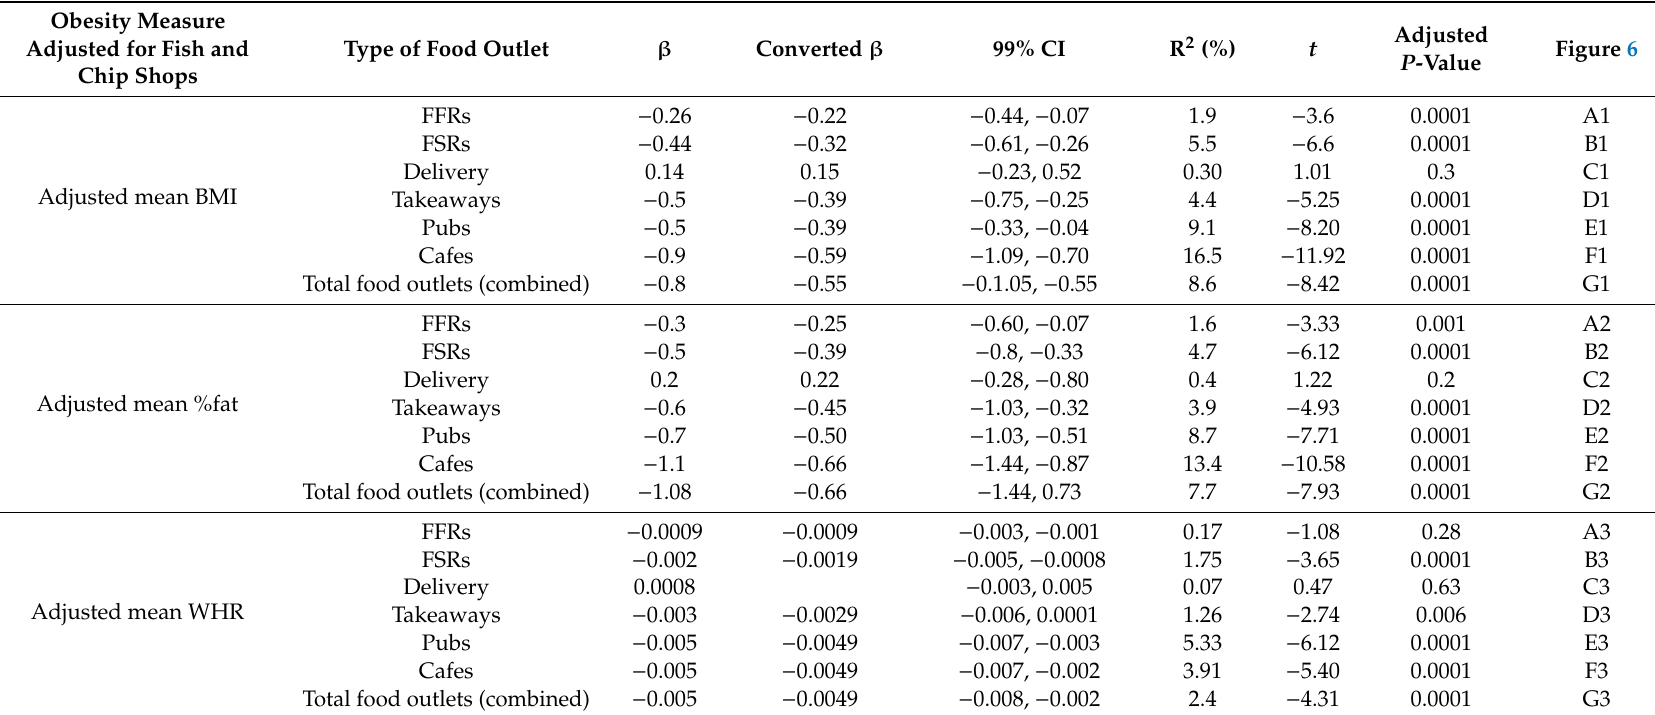
Figure 6 P -Value